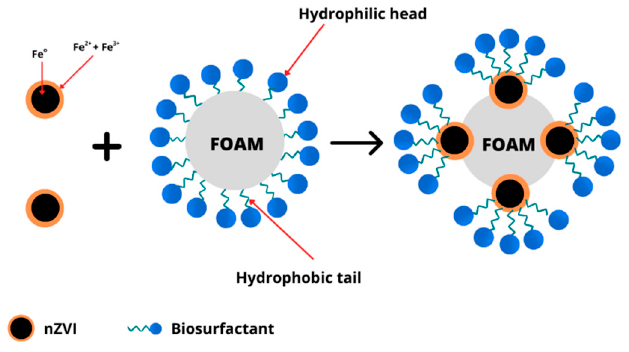
Figure 5. Interaction of surfactant foam and nZVIs.